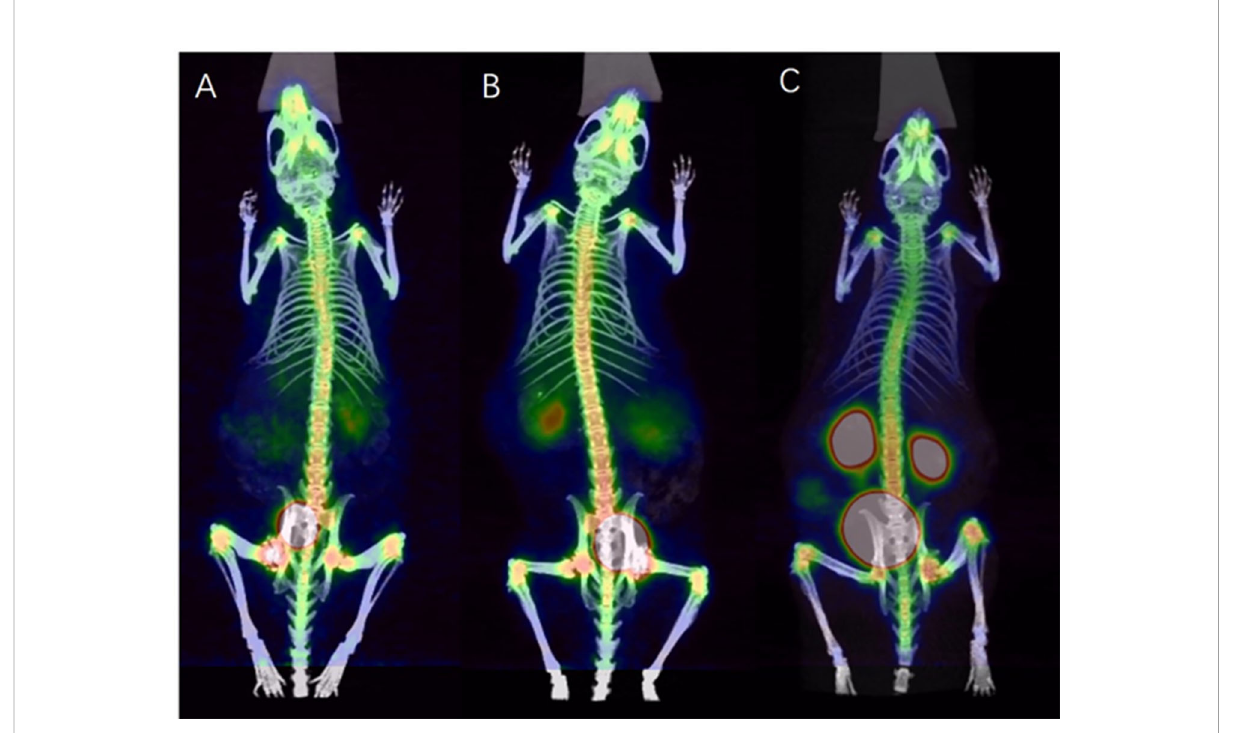
FIGURE 4 PET/CT images of 68 Ga-DOTA-IBA in normal mice at different time points [ (A) : 30 min; (B) :1.5 h; (C) :3